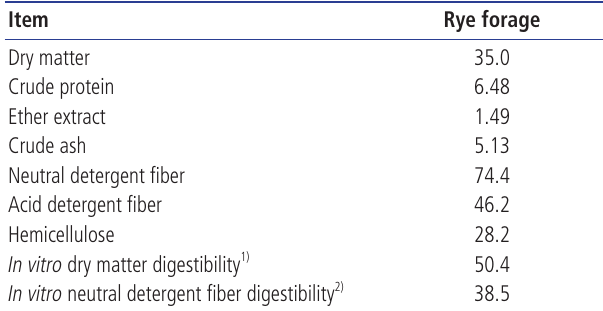
Table 1. Chemical compositions and in vitro digestibility of rye forage before ensiled (%, dry matter)